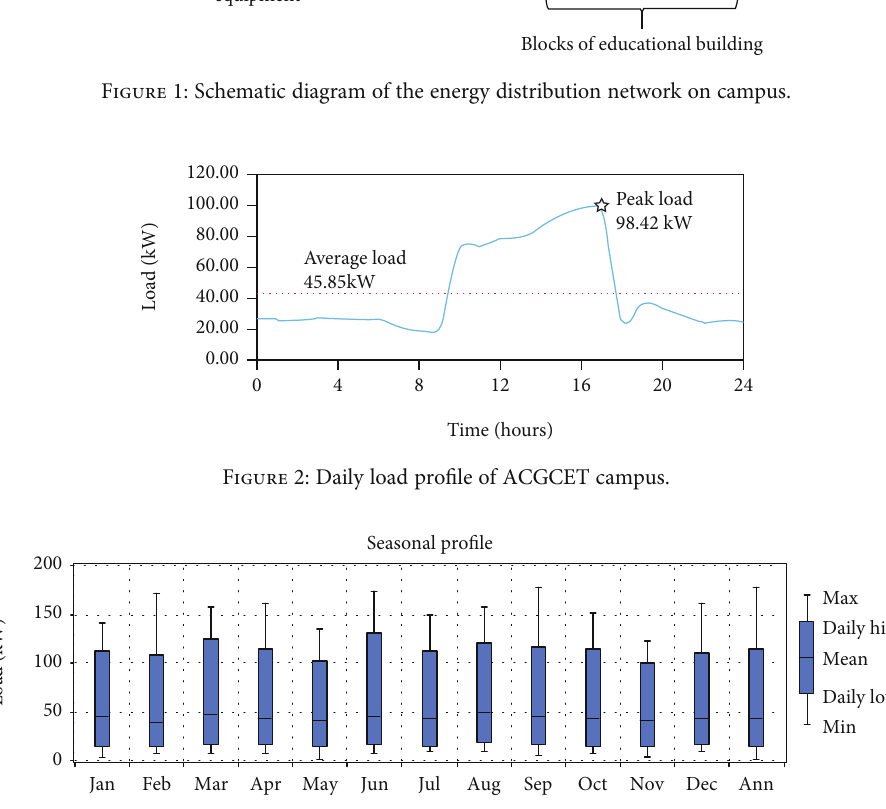
Figure 3: Load pro fi le of the ACGCET campus for each month in a